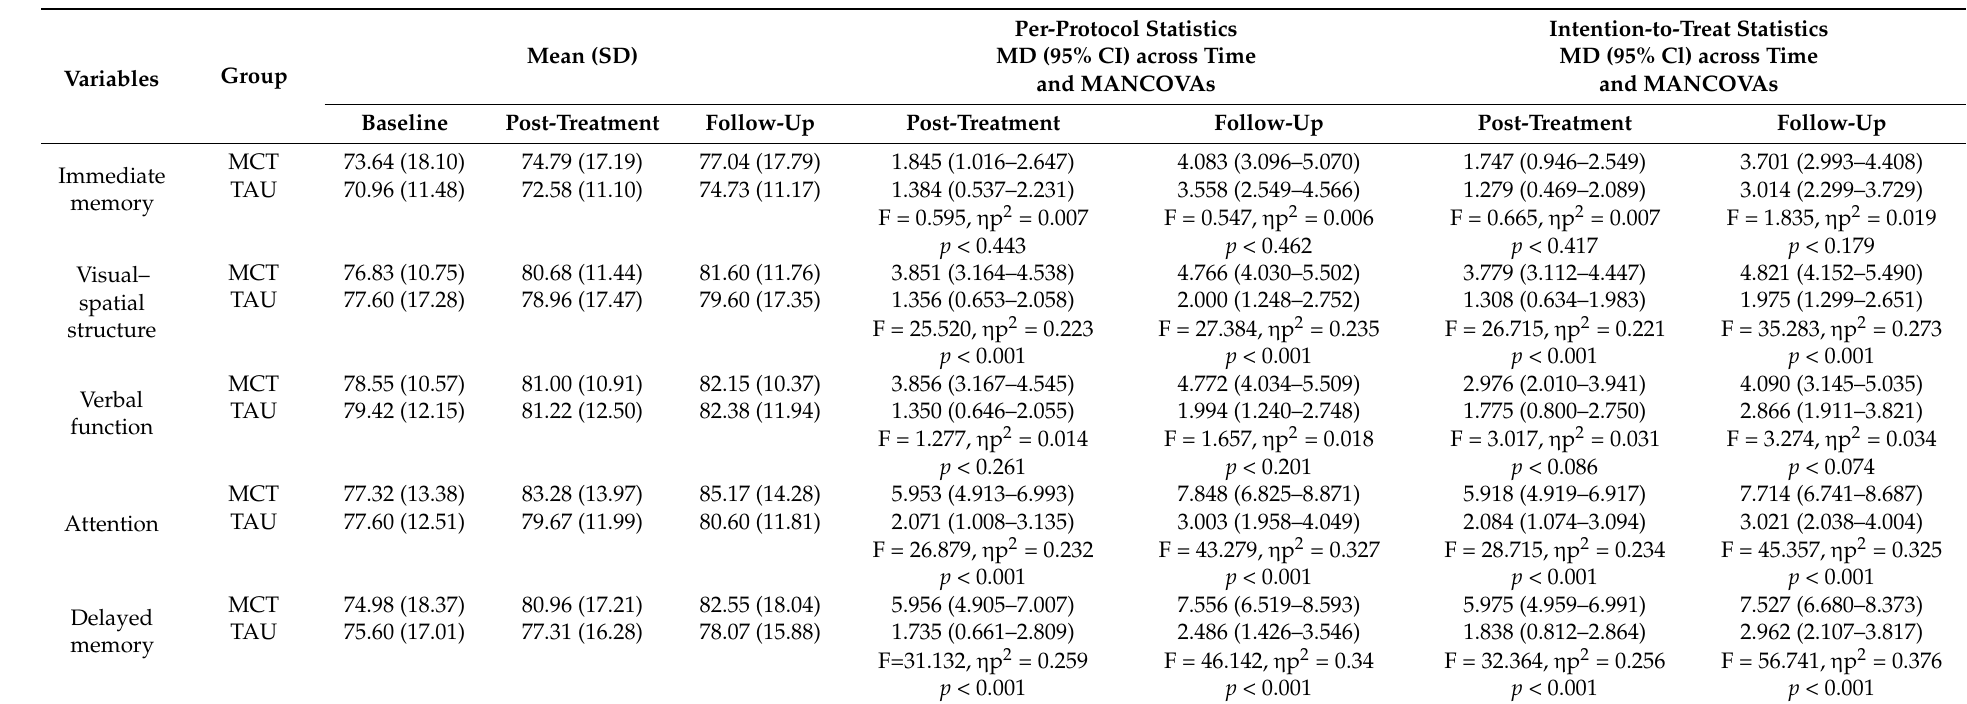
Table 3. Group differences across time on measures of cognitive function